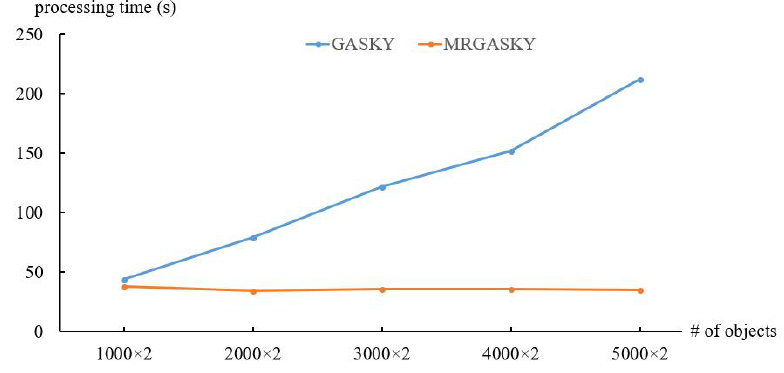
Figure 19. Processing Time of